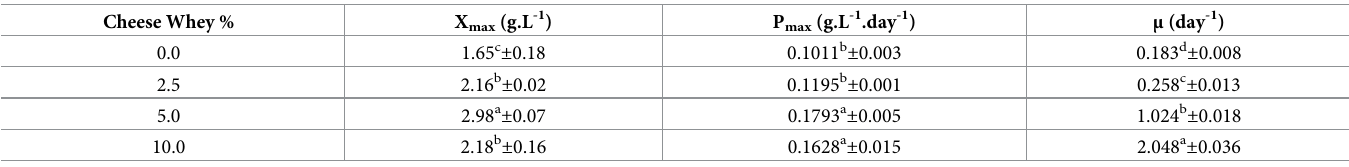
Table 2. Maximum biomass concentration (X max ), maximum yield (Y max ) and specific growth rate ( μ ) of S . platensis . Cheese Whey % X max (g.L -1